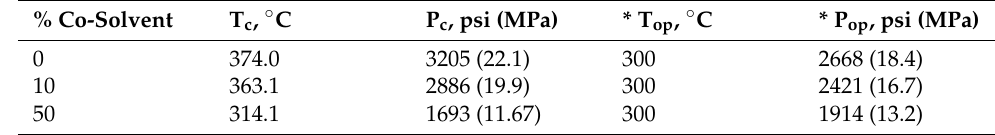
Table 1. Critical values and operating conditions of water–ethanol solvent mixtures. %